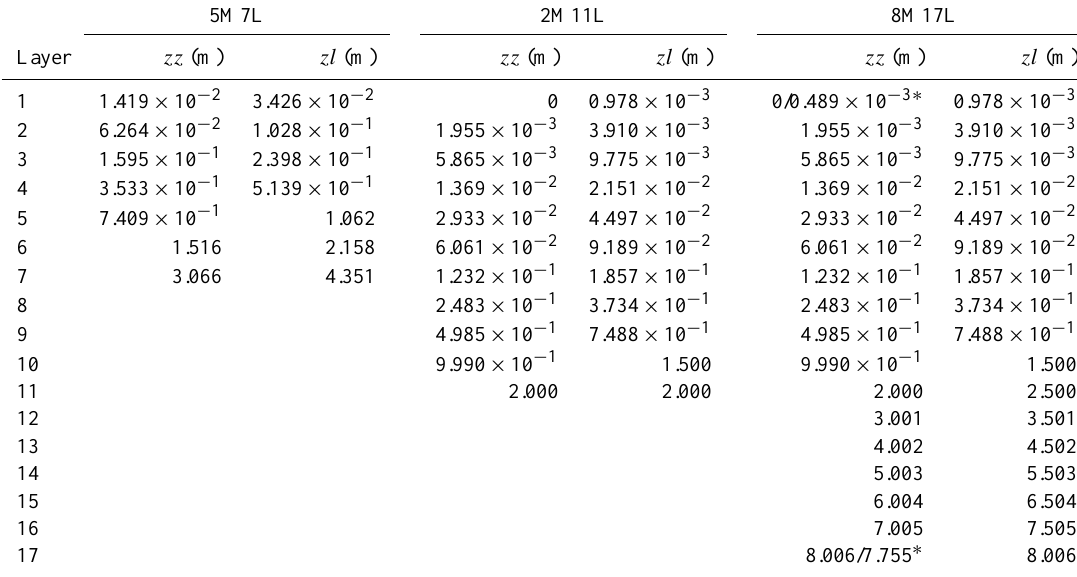
Table 3. The soil vertical discretizations of 5M7L, 2M11L, and 8M17L. 5M7L 2M11L 8M17L Layer zz (m) zl (m) zz (m) zl (m) zz (m) zl (m) 1 1.419 × 10 − 2 3.426 × 10 − 2 0 0.978 × 10 − 3 0/0.489 × 10 − 3